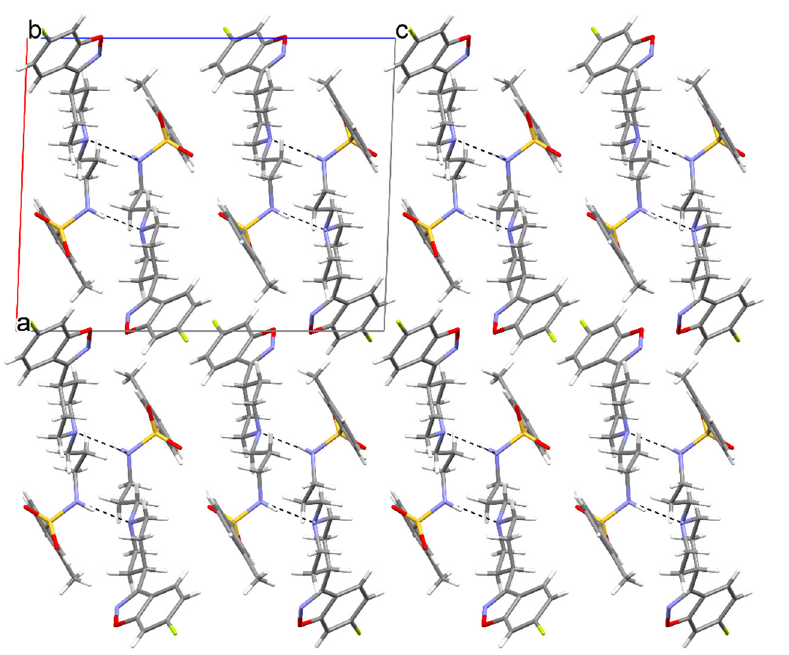
Figure 3. The crystal packing of MBS , viewed along the b axis, where ( a – c ) denote unit cell